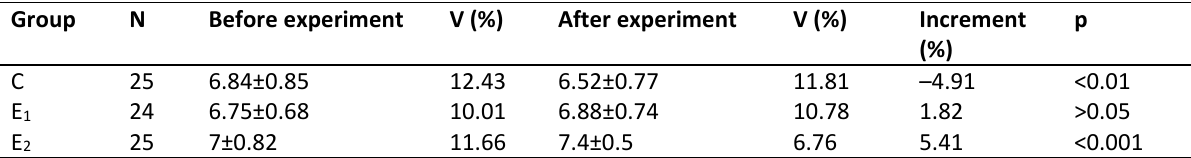
Table 2. Dynamic of operative memory indicators of economic specialties’ girl students in the course of pedagogic experiment (n=74) Group Before